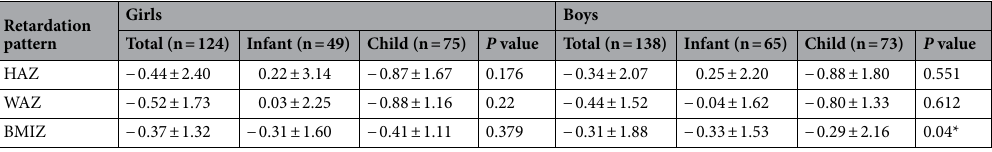
Table 1. The height, weight and BMI Z-scores of patients with TOF. z scores are shown as mean ± SD. Z scores of individuals from infant group and child group were compared using paired samples t test. * P < 0.05 was considered as significant